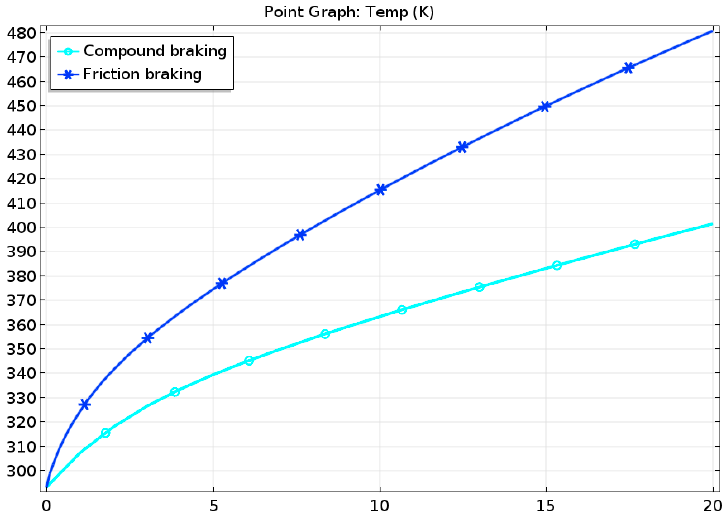
Figure 16. Contrast curves of temperature rise for two different braking forms.